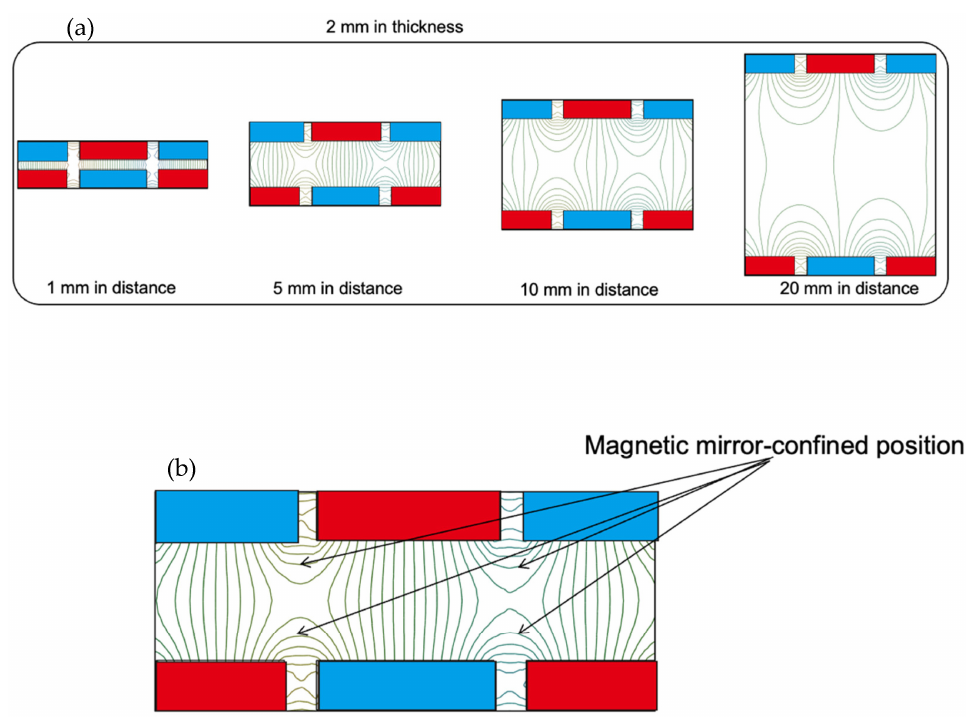
Figure 2. ( a ) Magnetic field lines inside the magnetic circuit calculated by the 2D finite element method for magnets with different distances. ( b ) Magnetic field lines inside the magnetic circuit in the case of 5 mm in distance.